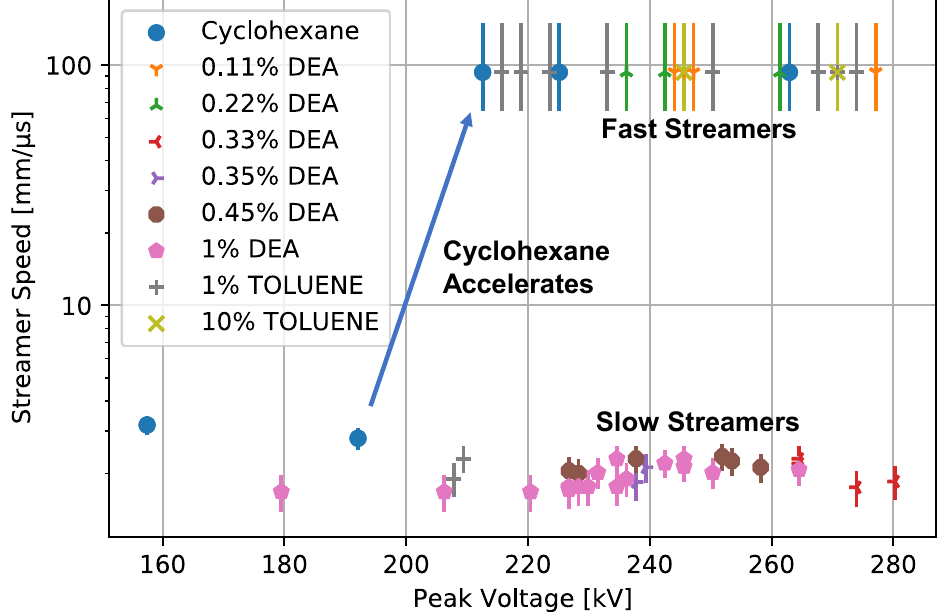
Figure 4. The approximate overall streamer velocity of streamers for various DEA and toluene mixtures in cyclohexane. Pure cyclohexane also shown for reference. Applied voltage was a positive polarity lightning impulse (1.2/50 µs) with a 70 mm gap (point-plane arrangement).